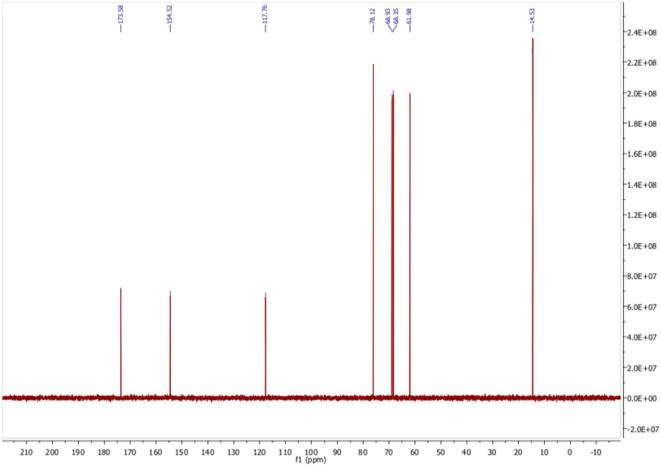
13C NMR spectrum of 3-o-ethyl-l-ascorbic acid in D2O.